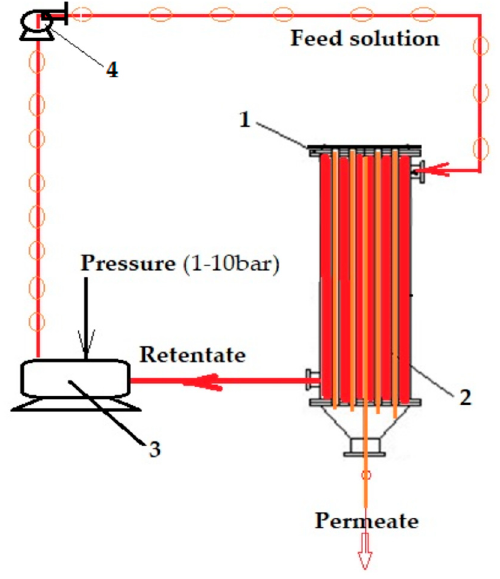
Figure 2. Schematic of the installation for pertraction: SP—source phase, RS—receiving phase. 1. Hollow-fiber pertraction module; 2. SP reservoirs; 3. RP reservoirs; 4. SP pump; 5. RP pump; 6. Thermostat.